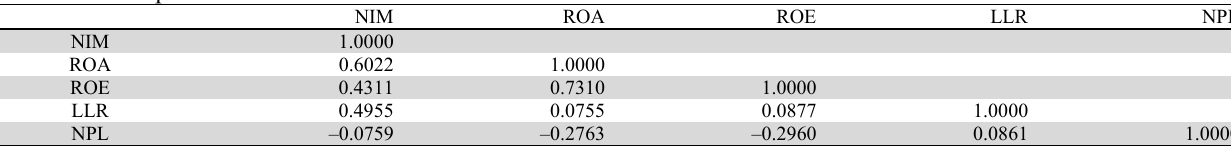
Correlation of dependent variables